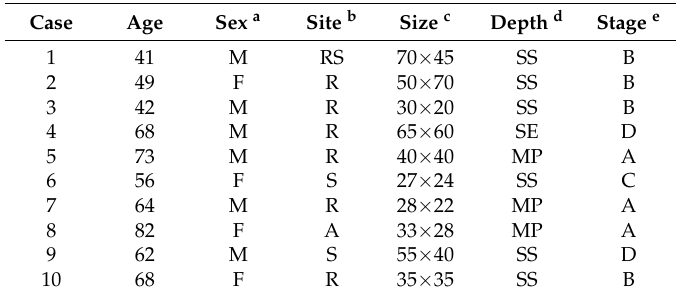
Table 1. Clinicopathological features in colorectal cancer patients.